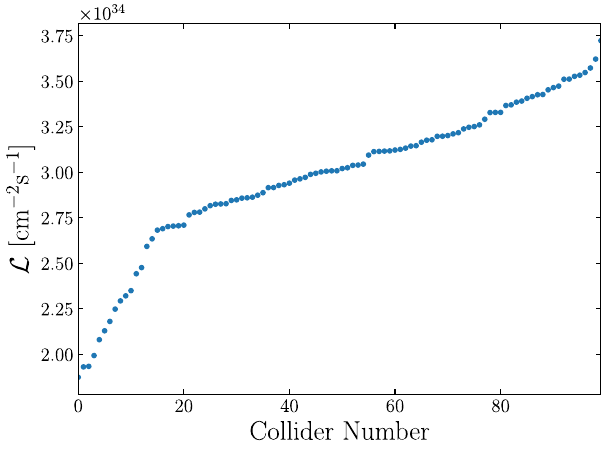
FIG. 8. Vertical position jitter at the IP σ y;j that corresponds to a luminosity loss of 3 × 10 32 cm − 2 s − 1 for 100 tuned colliders with static imperfections. Colliders are ordered in ascending position